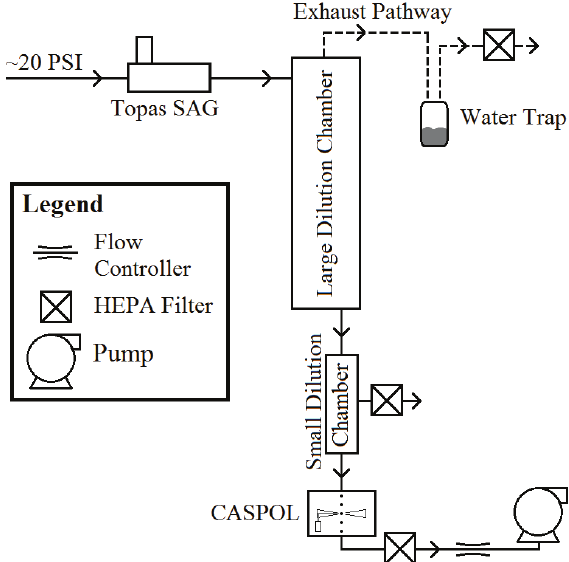
Fig. 3. Experimental setup for CASPOL dust